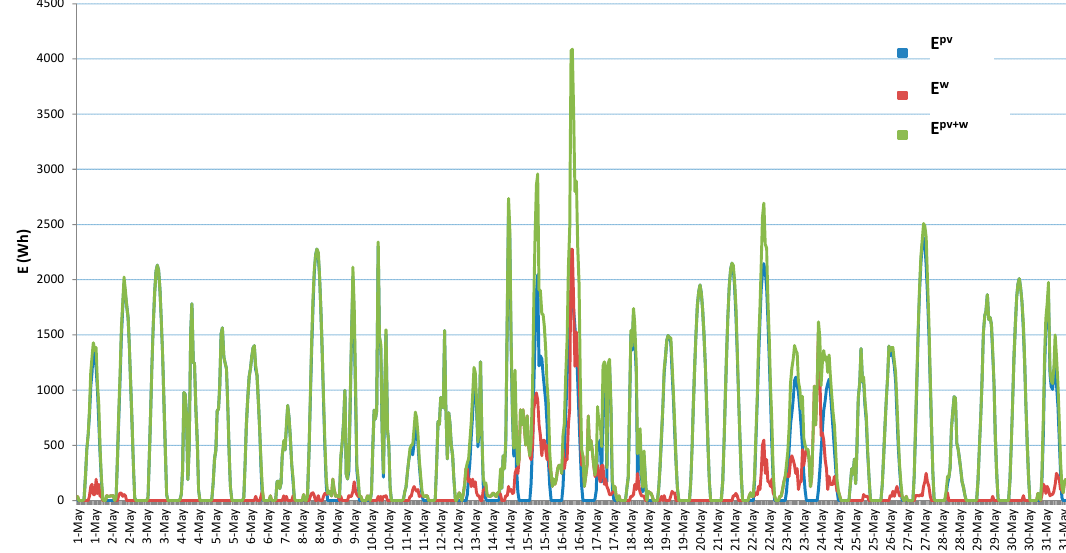
Figure 7. Time evolution of the generation in May.